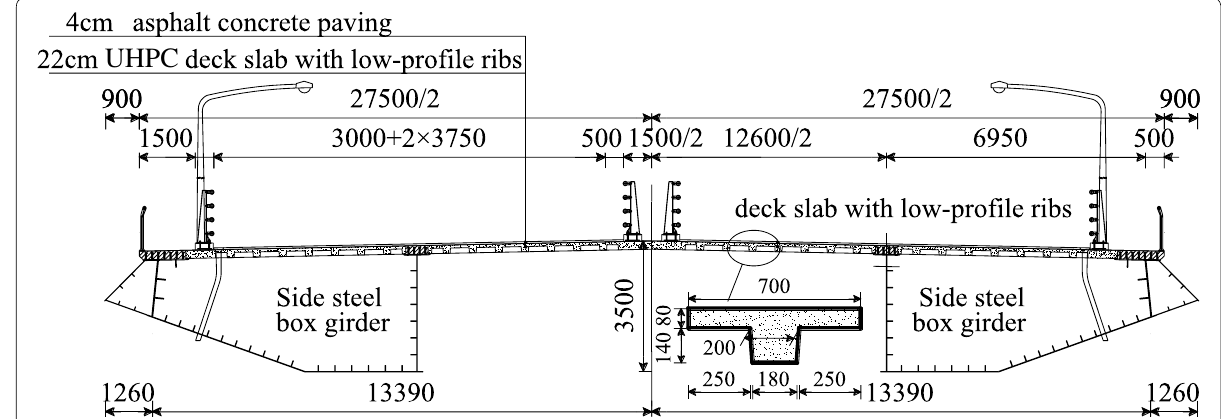
Fig. 1 Scheme of steel-UHPC composite girder [unit: mm, in reference (Kong et al.